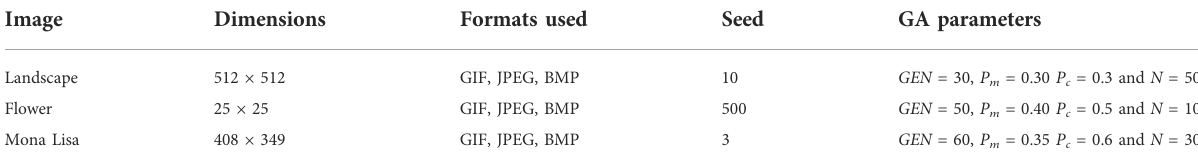
TABLE 2 Cover image characteristics and parameters of the GA used in the tests